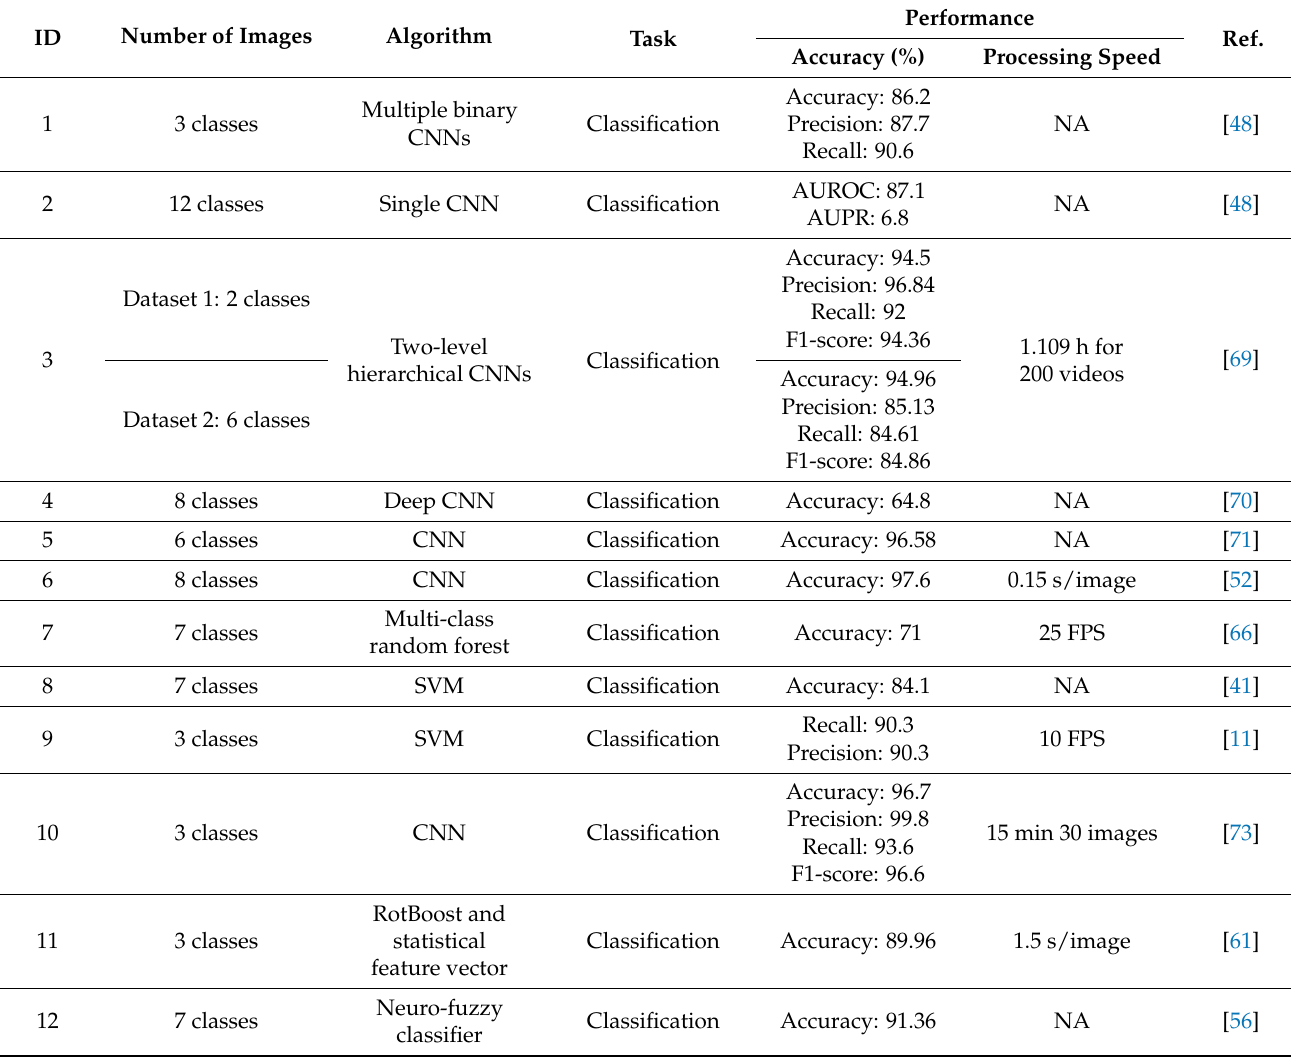
Table 8. Performances of different algorithms in terms of different evaluation